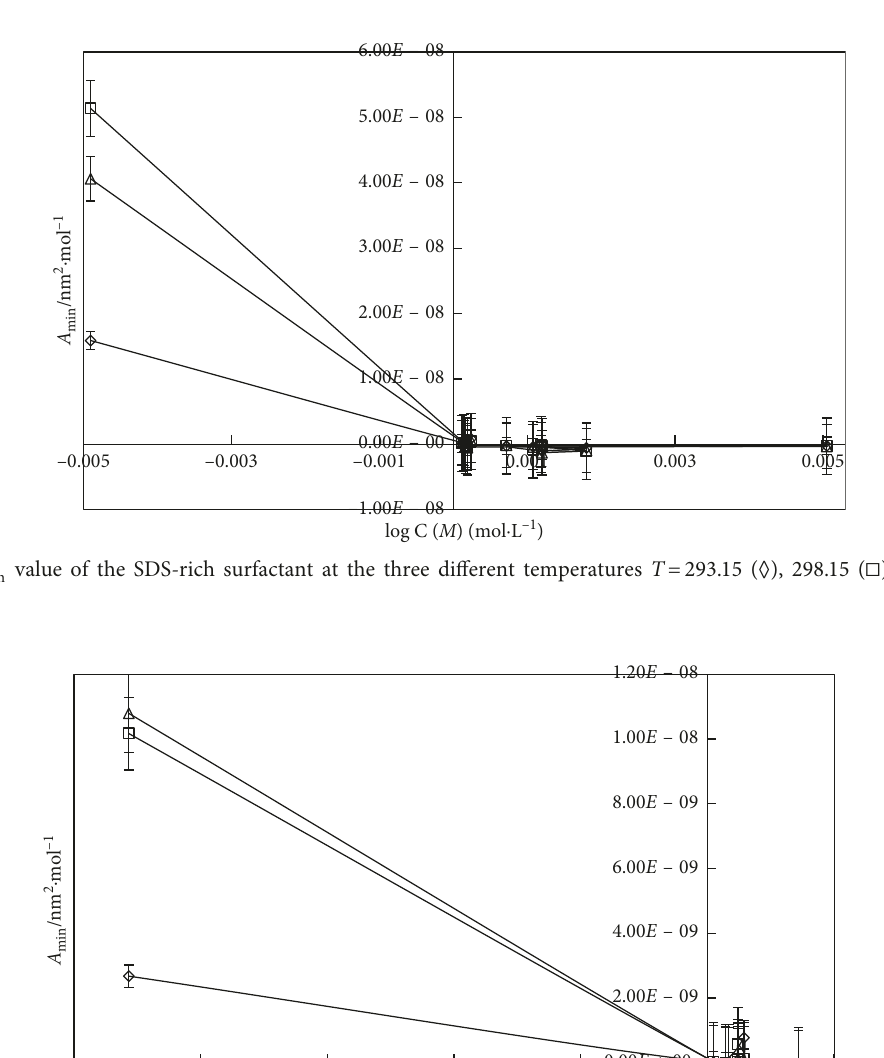
value of the DTAB-rich surfactant at the three different temperatures T � 293.15 ( ◊ ), 298.15 ( □ ), and 303.15 K ( △ ),